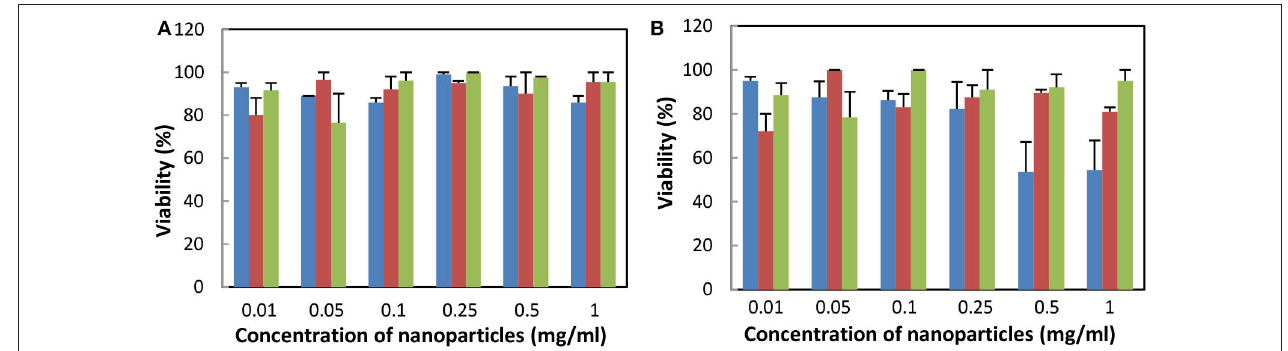
FIGURE 3 | Dependence of viability of (A) Hep-G2 and (B) HeLa cells on the concentration of NaYF 4 :Yb 3 + /Er 3 + @NaYF 4 :Nd 3 + (blue), NaYF 4 :Yb 3 + /Er 3 + @NaYF 4 :Nd 3 + -PEG 5,475 -Alk (red), and NaYF 4 :Yb 3 + /Er 3 + @NaYF 4 :Nd 3 + -PEG 5,475 -RGDS nanoparticles (green) using the trypan blue exclusion test. All differences between data were statistically non-significant, except for blue vs. other two bars at concentration 0.5 and 1 mg/ml for Hela cells, where P <